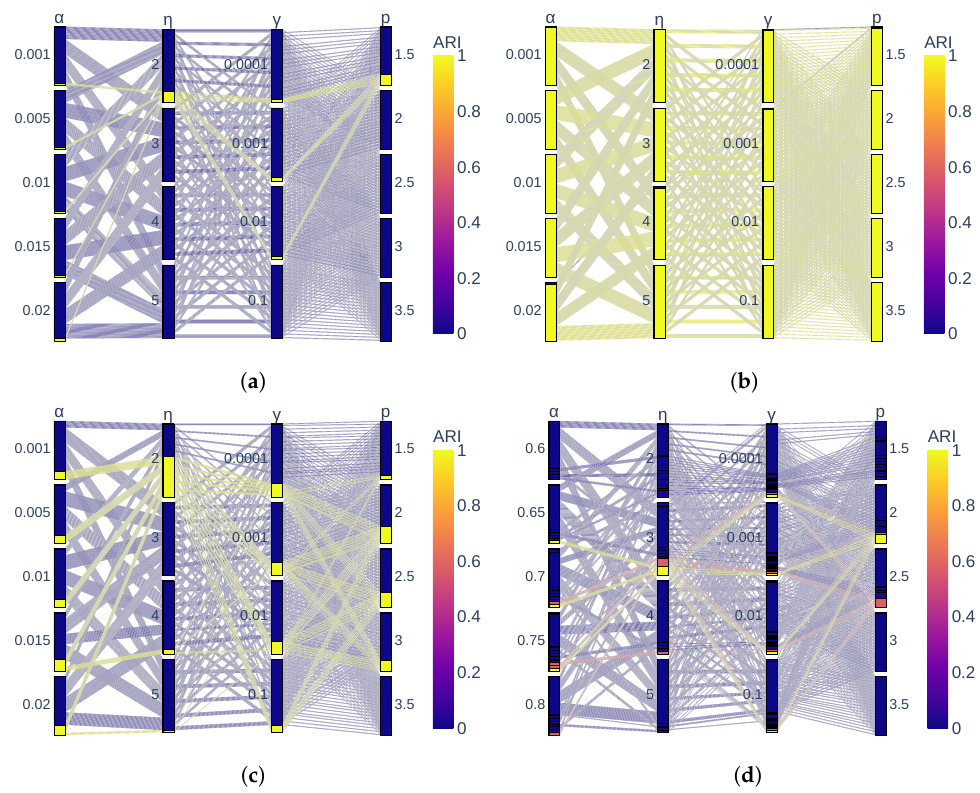
Figure 13. Variation of Macro SOStream hyperparameters and ARI metric values. ( a ) Clustering with the Horseshoe dataset. ( b ) Clustering with the T dataset. ( c ) Clustering with the Moon dataset. ( d ) Clustering with the Three Spirals